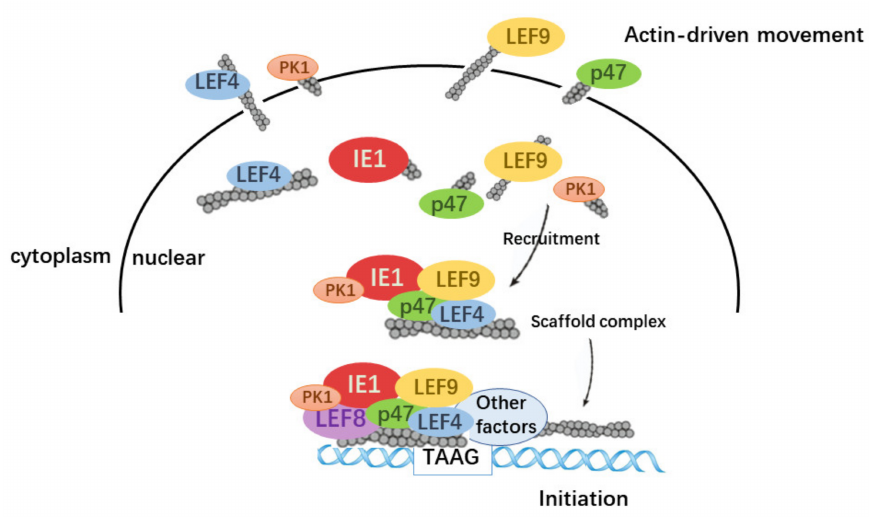
Figure 7. Summary model for the regulatory roles of actin play in baculovirus polymerase transcrip- tion. A model of how actin dynamics assists in the hyperexpression in the baculovirus expression vector